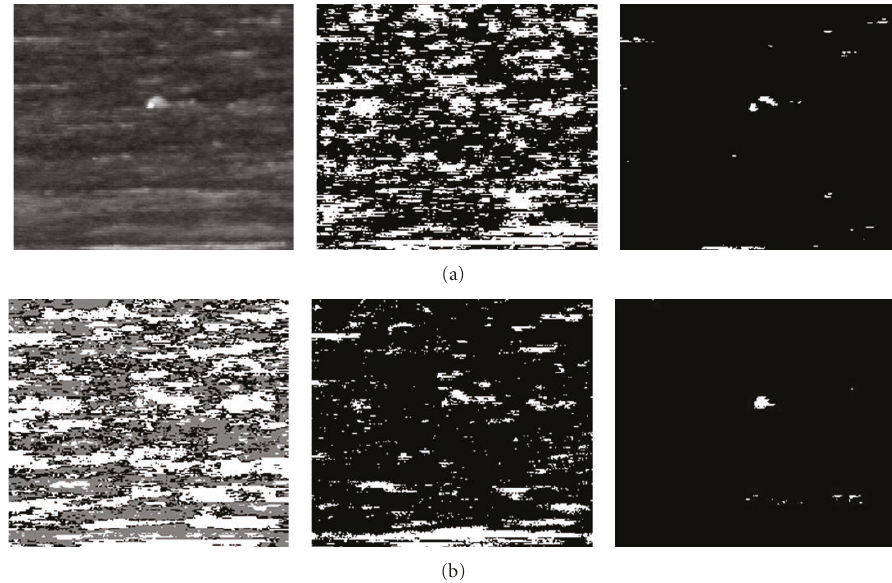
Figure 9: MW33 sequence in the 3–5 μm band. From left to right, (a): original, mean, gmm. (b): EGMM, ViBe, behaviour subtraction.